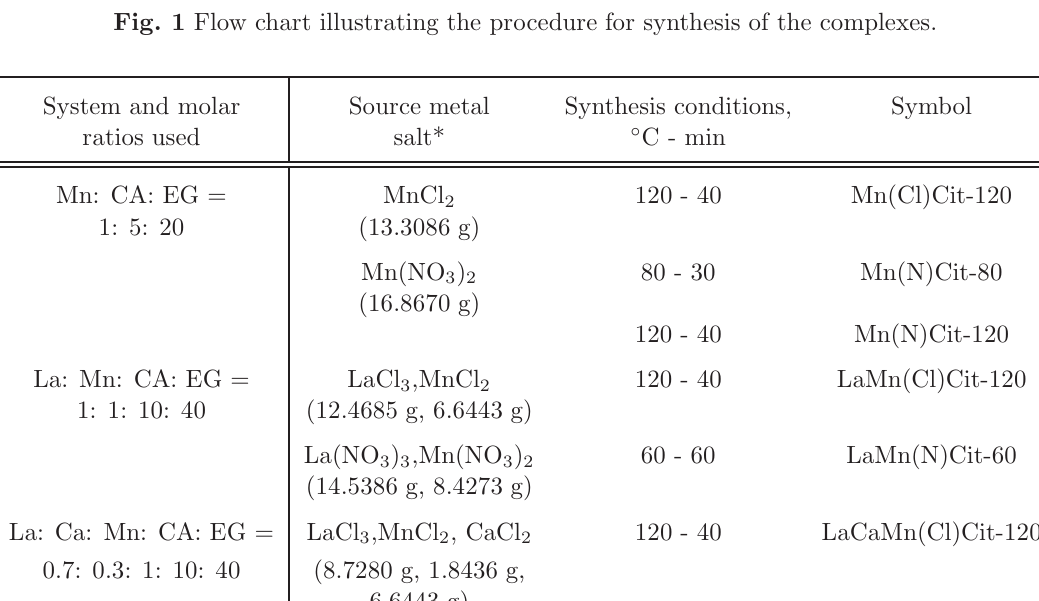
Fig. 1 Flow chart illustrating the procedure for synthesis of the complexes.